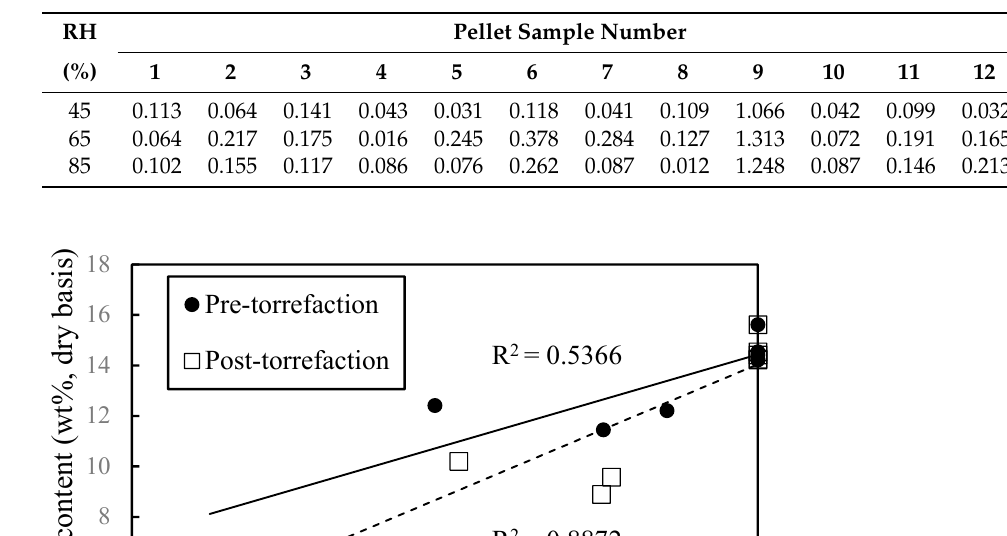
Table 2. Standard deviation value for equilibrium moisture content at each relative humidity (RH) condition.